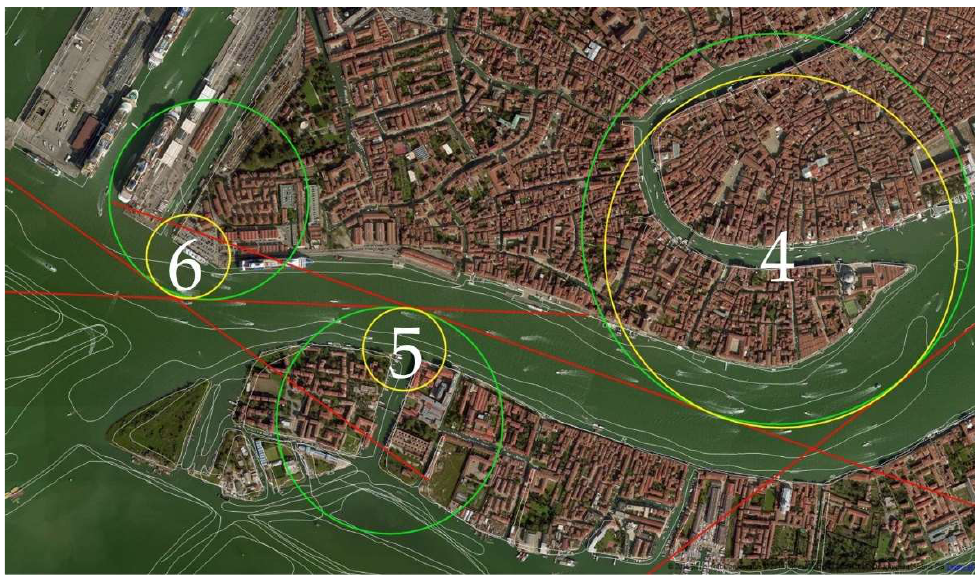
Figure 8. First (green, larger) and last (yellow, smaller) evolution circles in the Venetian Canal.